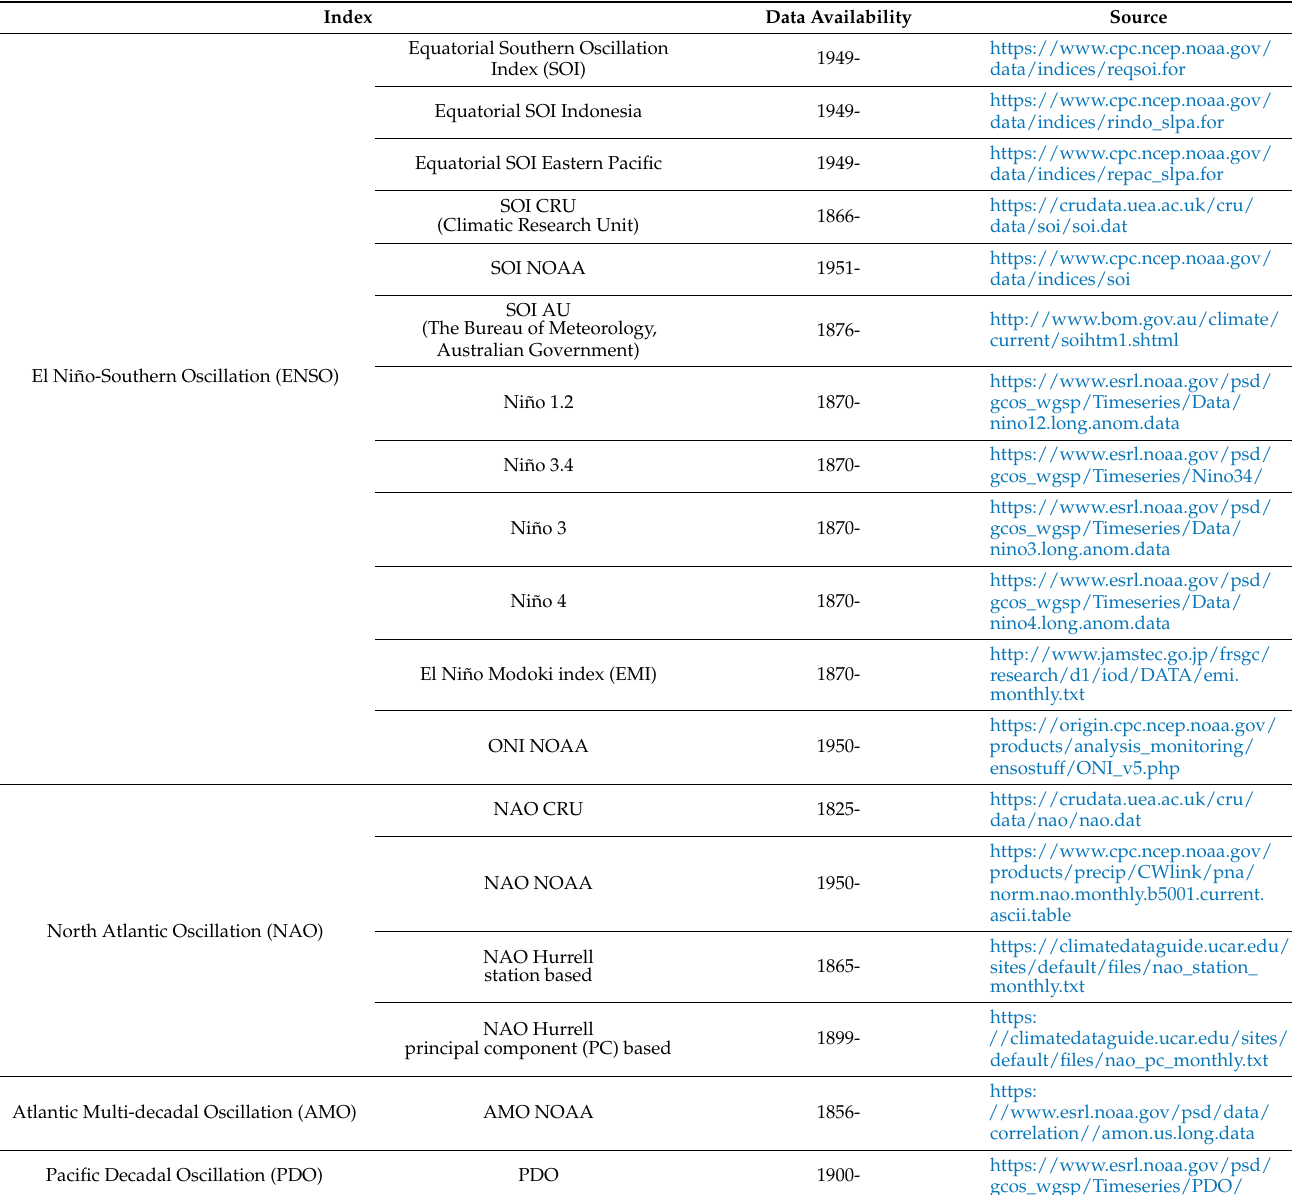
Table 1. Information (meta-data) about the ocean–atmosphere oscillation indices considered in this paper. There are no missing values in datasets. All data are given as monthly values, except for the Oceanic Niño Index (ONI) NOAA (National Oceanic and Atmospheric Administration), where record values are 3-month running means. In contrast to other indices, with constant reference periods (mostly 1981–2010), the reference period for ONI NOAA is a centered 30-year base period updated every 5 years. Data used for analysis were retrieved on 7 July